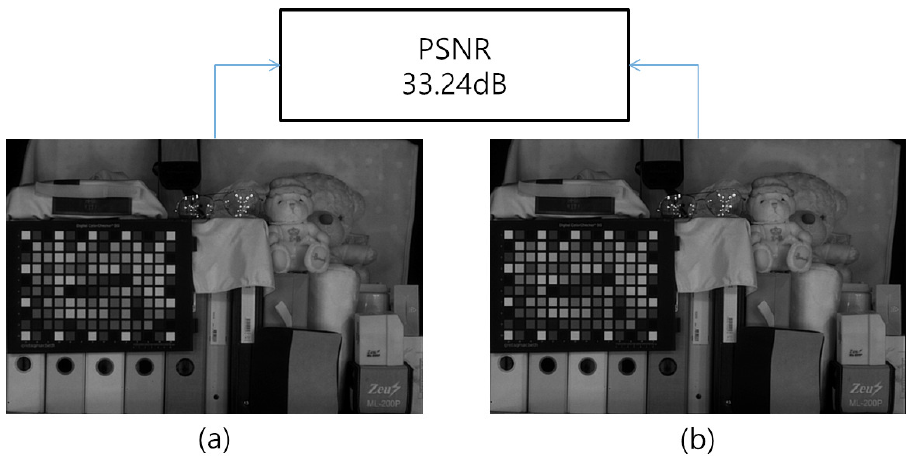
Figure 9. Comparison between ( a ) the optical filtered N channel image and ( b ) the estimated N channel image in NIR